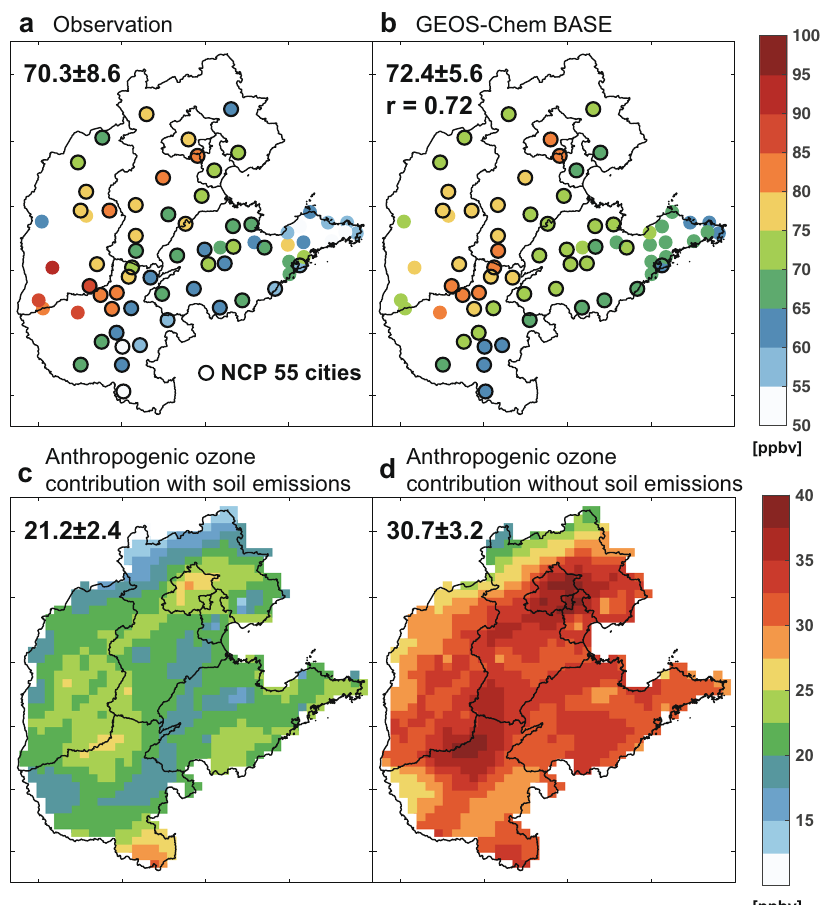
Fig. 2 Soil NO x emission in fl uences on surface ozone levels and estimated anthropogenic ozone contribution. Panels a and b show the spatial distribution of a observed and b simulated mean MDA8 ozone at urban sites over the NCP in July 2017. Mean values ± standard deviation and their spatial correlation coef fi cients ( r ) in the 55 NCP cities categorized as key cities for air pollution monitoring (marked with black circles) are shown in the inset. Panels c, d show ozone contributions from domestic anthropogenic emissions, estimated as the simulated ozone difference with domestic anthropogenic sources turned on/off, in the presence/absence of soil NO x emissions (Methods). The mean values ± standard deviation over the NCP grids are shown in the